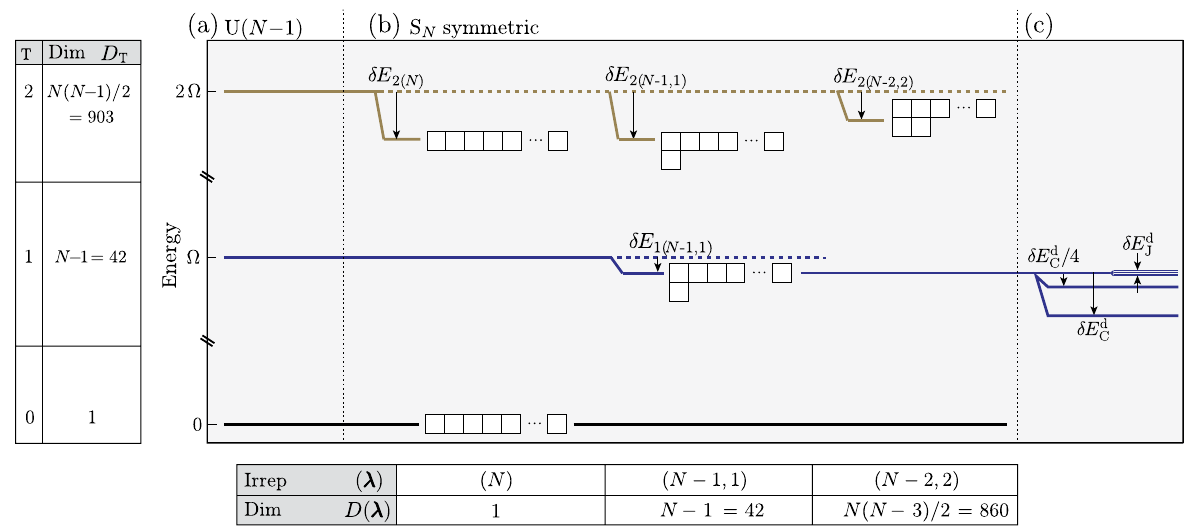
FIG. 4. Difference-mode spectrum for total excitation numbers T ¼ 0 ; 1 ; 2 . (a) Within the harmonic approximation, S N and U ð N (cid:3) 1 Þ symmetry hold and produce degenerate subspaces of dimension (dim) D leaves S N symmetry intact. The irreducible representations (irreps) of S N , labeled by partitions ð (cid:9) Þ or Young diagrams, give rise to D ð (cid:9) Þ -dimensional degenerate subspaces. (c) Corrections from disorder in array-junction E break S N symmetry. The degeneracy lifting is shown for the T ¼ 1 subspace.